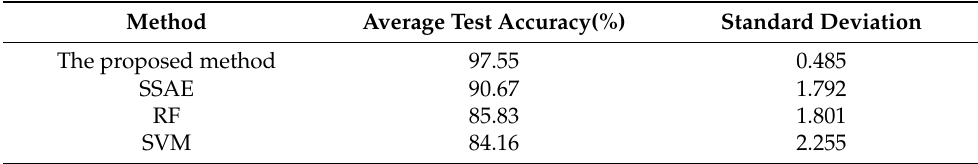
Table 3. The average accuracy and standard deviation.